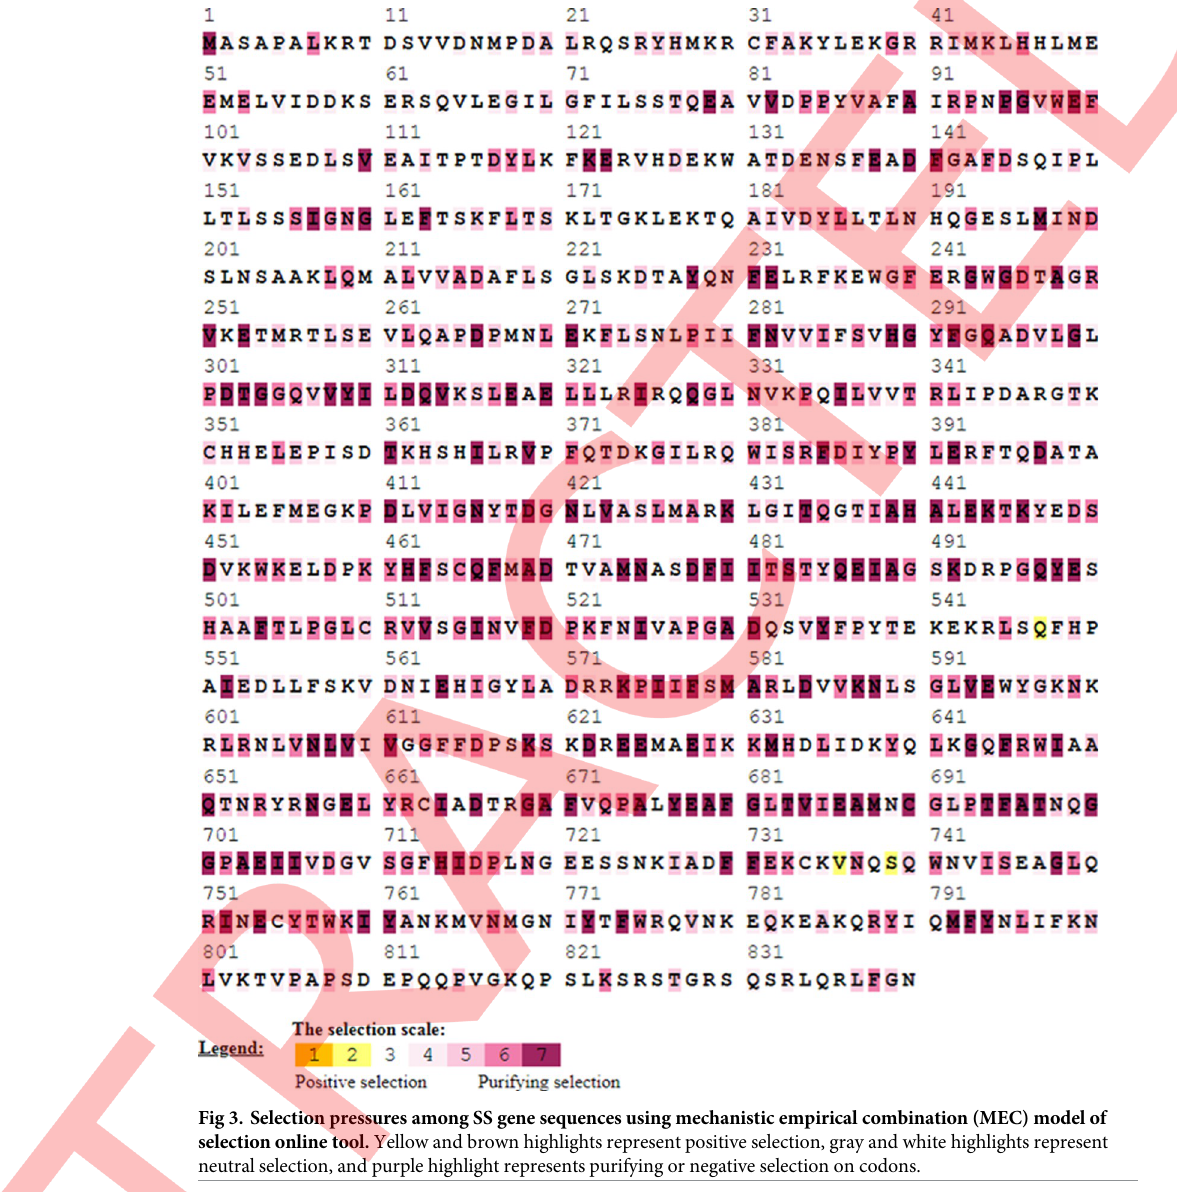
Fig 3. Selection pressures among SS gene sequences using mechanistic empirical combination (MEC) model of selection online tool. Yellow and brown highlights represent positive selection, gray and white highlights represent neutral selection, and purple highlight represents purifying or negative selection on